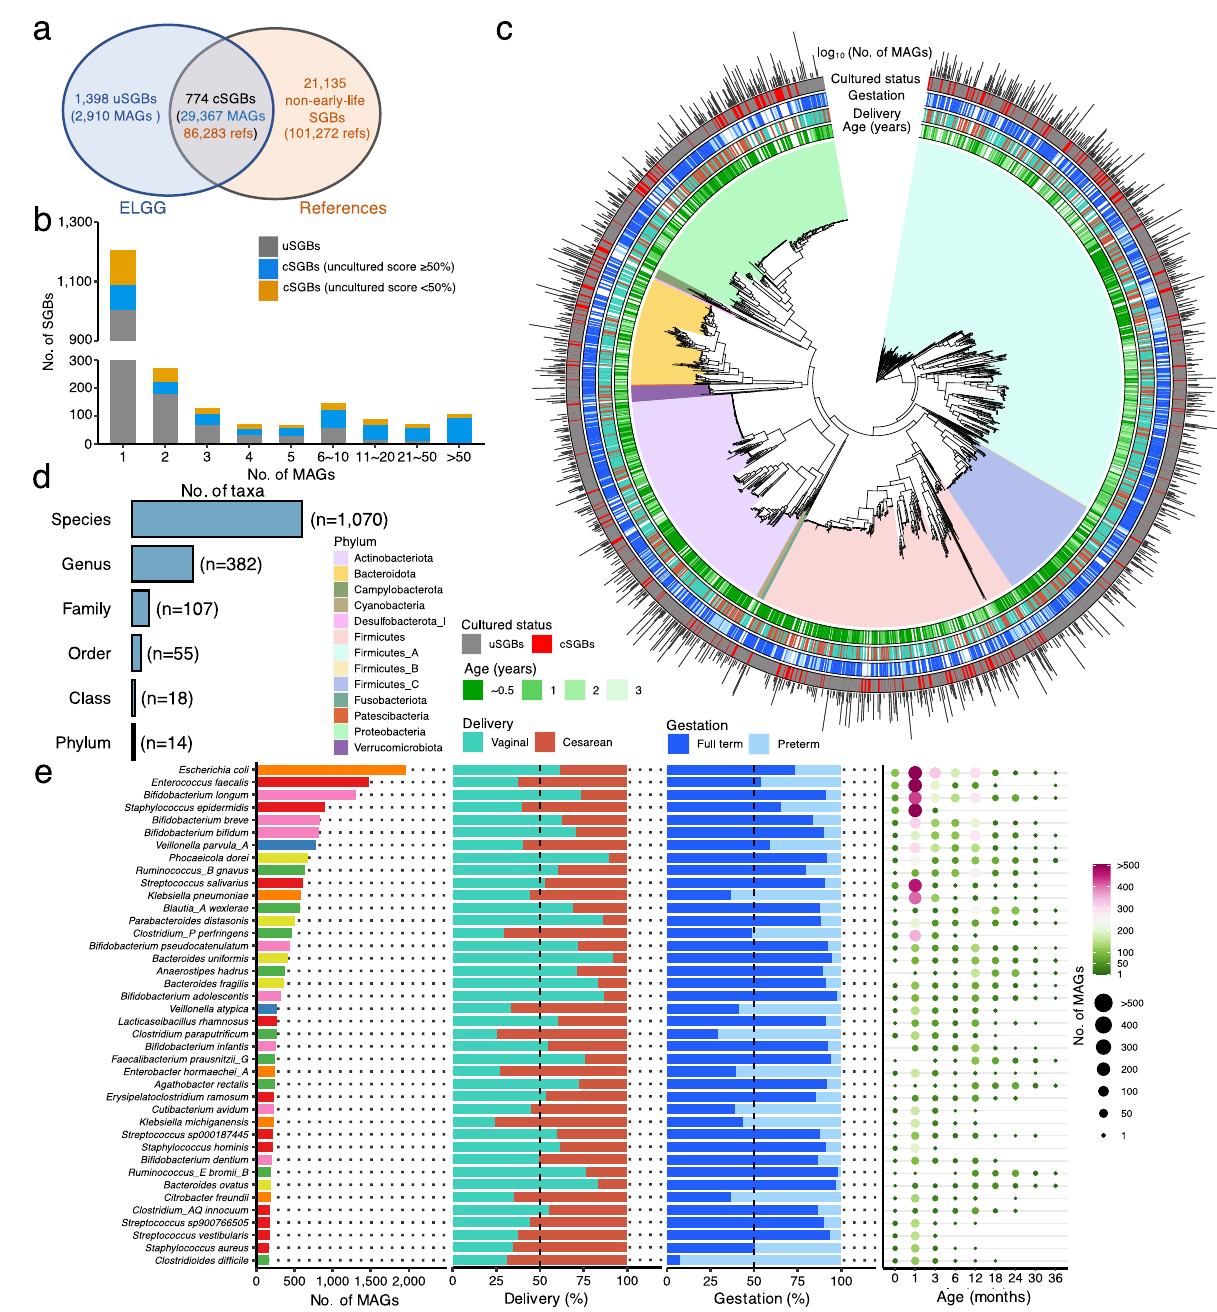
Fig. 3 | A total of2172 species-level clusters (SGBs) obtained from 32,277 early- life MAGs. a Overlap of SGBs containing both MAGs and isolate reference gen- omes.SGBscontainingMAGsandreferencegenomesaredenotedasculturedSGBs (cSGBs), SGBs without reference genomes are denoted as uncultured SGBs (uSGBs), and those exclusively containing reference genomes are denoted as non- early-life SGBs. b The number of cSGBs and uSGBs as a function of the genome number within each SGBs. The uncultured score is calculated as the proportion of